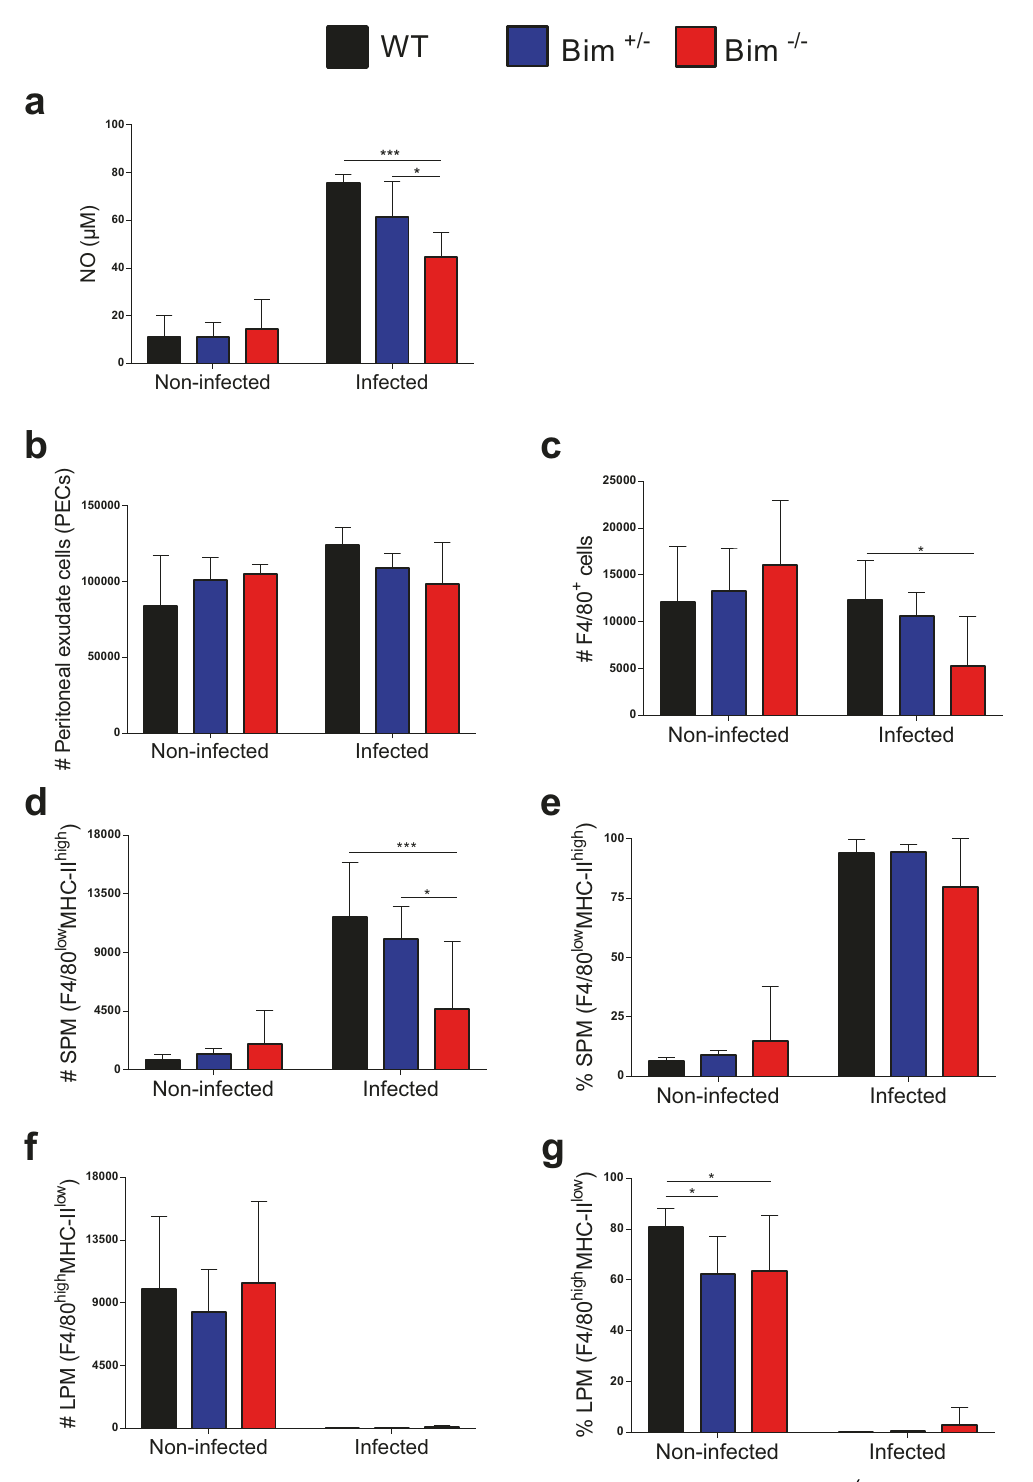
Fig. 2 Impaired NO secretion and de fi cient in fl ux of SPM subpopulation to the peritoneal cavity of Bim − / − mice at peak parasitemia. WT, Bim + / − , and Bim − / − C57BL/6 mice were infected (i.p.) or not with 1 × 10 4 trypomastigotes of the Y strain of T. cruzi . After 9 days, PECs were isolated, cultured for 48 h with no further stimulation, and the concentration of nitric oxide was determined by the Griess reaction ( A ). In addition, PECs were labeled with a mixture of monoclonal antibodies against CD19, CD11c, F4/80, and MHC-II and analyzed by fl ow cytometry. The gating strategy used was based on FSC-A x FSC-H to exclude doublets, CD19 x FSC-H to exclude B cells, CD11c x FSC-A to exclude dendritic cells, F4/80 x SSC-A to select the population of F4/80 + macrophages and, fi nally, F4/80 x MHC-II to analyze the percentage and distribution of SPM and LPM subpopulations ( B – G ). The results are expressed as the average and standard deviation of 5 animals for the infected groups and 3 animals for the non-infected groups. All results are representative of 3 independent experiments and are expressed as the mean and standard deviation of triplicate samples. Statistical analysis was performed using two-way ANOVA, followed by Bonferroni post- test. * p < 0.05, *** p <